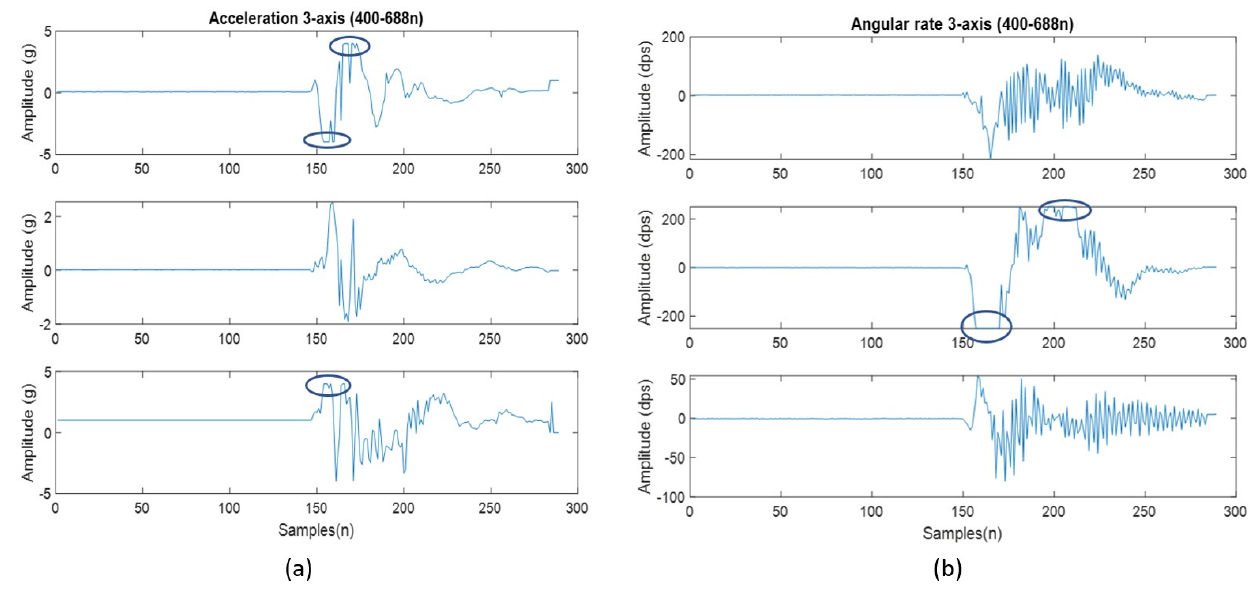
Figure 4. This figure shows the 3-axis and saturation points for ( a ) acceleration at 1.75 m and ( b ) gyroscope at 1.75 m.